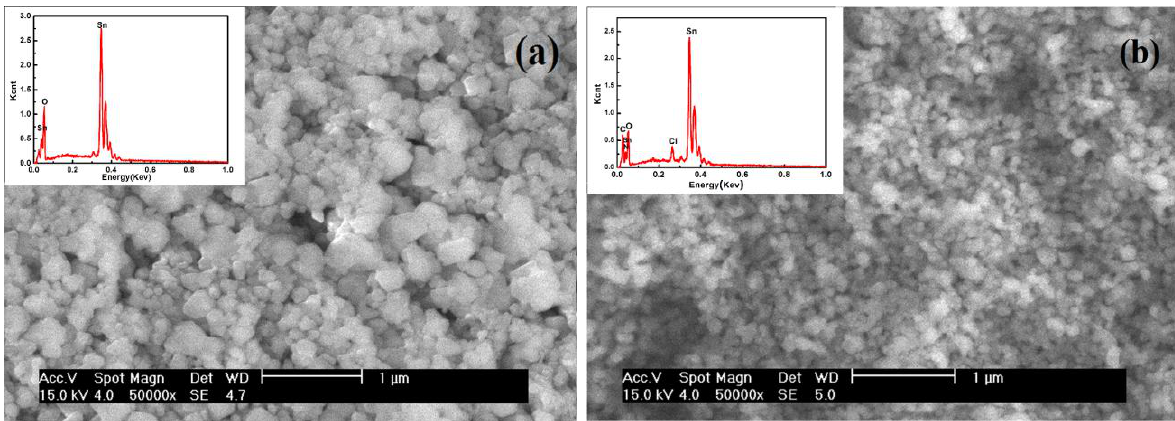
Figure 5. Surface morphology of the sensing film at the same magnification, ( a ) SnO ( b ) SnO -PDDAC. The inset reports the EDX spectrum collected from the 2